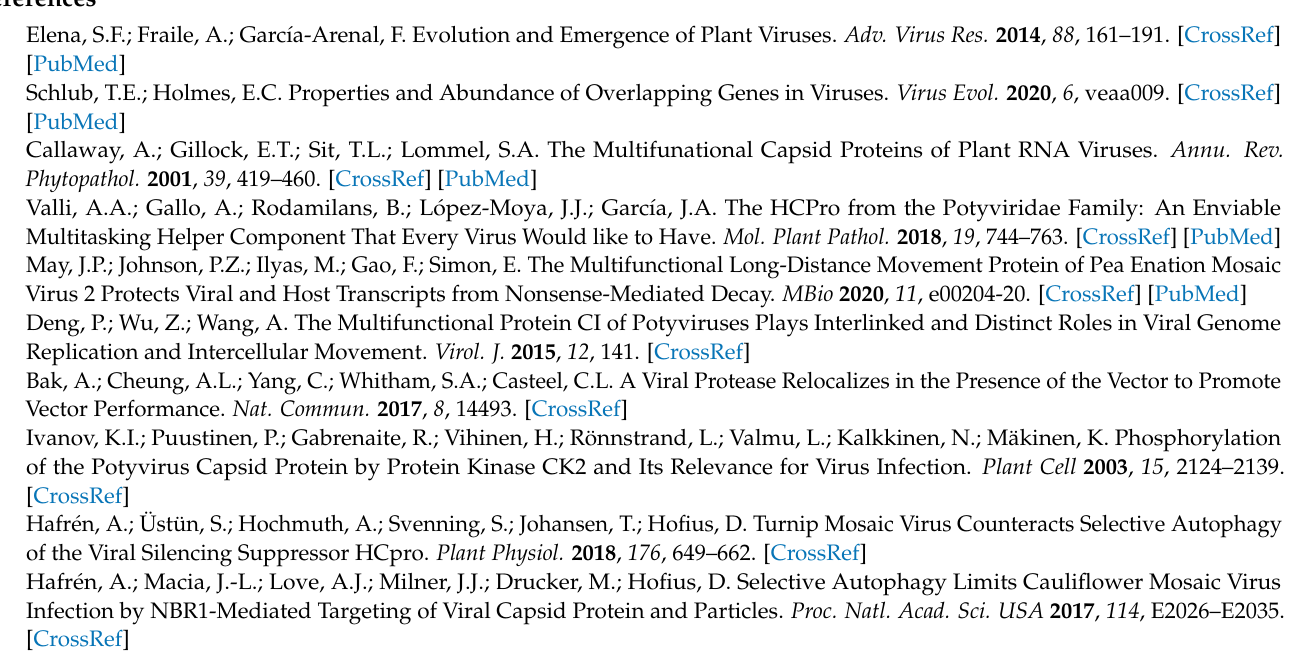
A list of primers used for quantification. Table S2: Enriched biological processes (BPs) during the A. thaliana interaction with Myzus persicae aphids. Table S3: Enriched BPs during the A. thaliana interaction with turnip mosaic virus (TuMV). Table S4: Enriched BPs during the A. thaliana interaction with a combination of both M. persicae aphids and